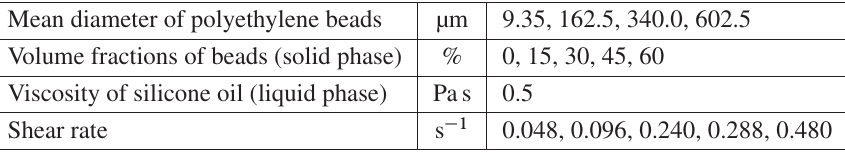
Table 1. Experimental conditions for the viscosity evaluation of suspensions at room temperature.